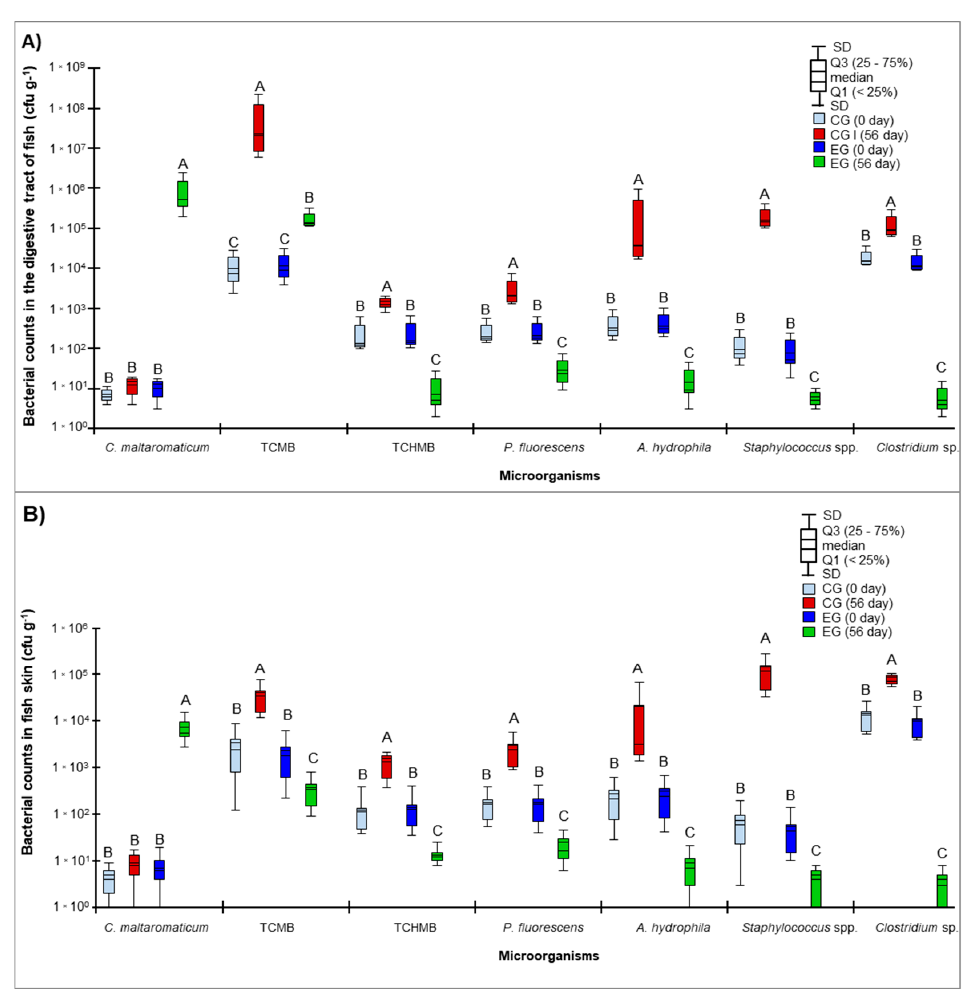
Figure 2. Bacterial counts (third quartile, median, standard deviation) (cfu g − 1 ) in the digestive tract ( A ) and skin ( B ) of the control (CG) and experimental groups (EG) of juvenile rainbow trout administered Aller Gold commercial feed and the same feed supplemented with 0.1% of the Carnobacterium maltaromaticum environmental probiotic strain, respectively. The numbers marked with different superscript letters differ significantly (ANOVA; p < 0.05; n = 30). Denotations: 0 day—first day of experiment, 56 day—last day of experiment, TCMB—total counts of mesophilic bacteria; TCHMB—total counts of hemolytic mesophilic bacteria.